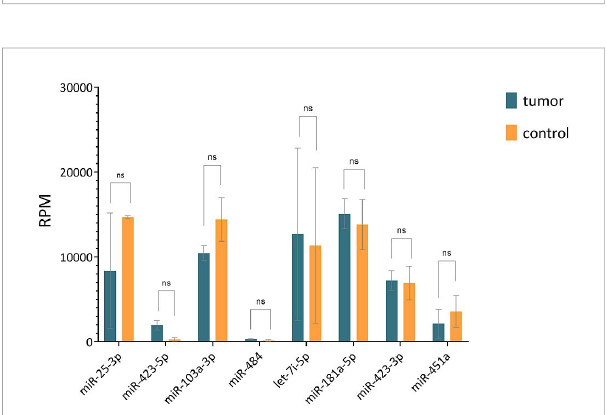
FIGURE 3 Comparison of RPM values of 8 selected endogenous controls obtained from sequencing analysis of tumor and control groups. Horizontal lines represent median values and error bars indicate 95% con fi dence intervals. The abbreviation "ns" means not signi fi cant